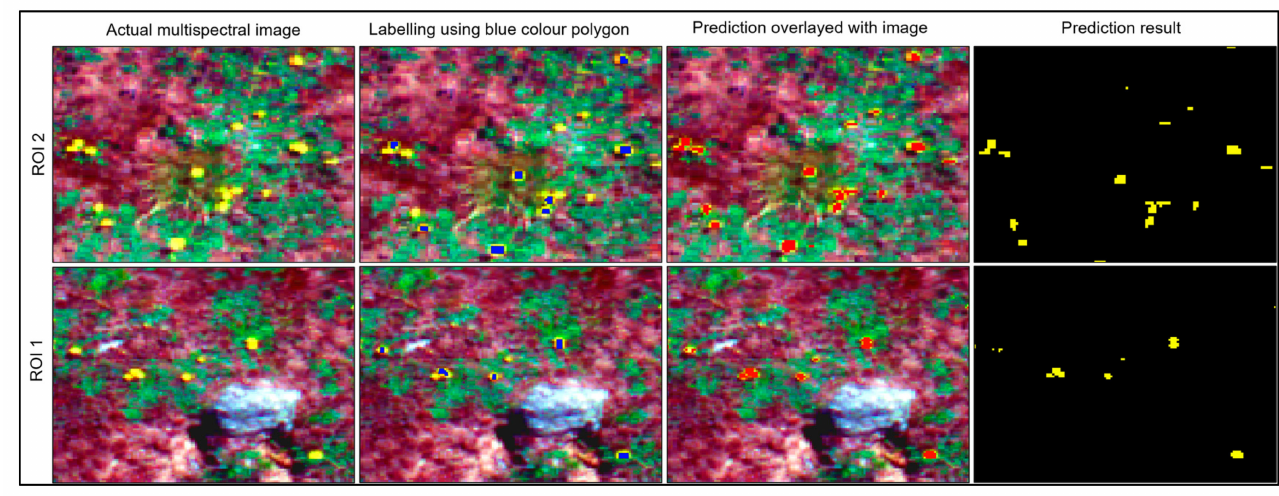
Table 7. Overall validation accuracy of different machine learning models for detection of hawkweed flowers at 0.65 cm/pixel. XGB SVM RF